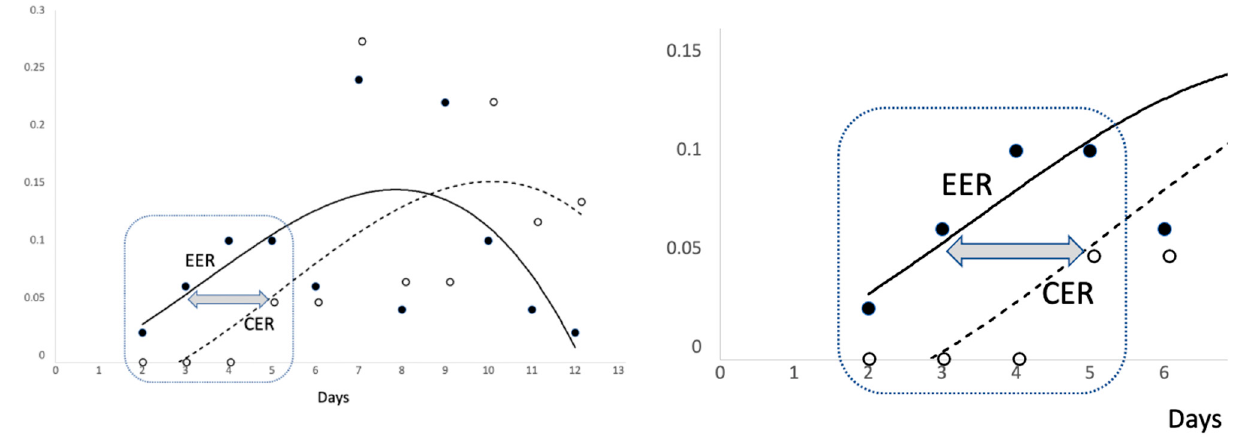
Figure 4. Experimental event rate (EER) and control event rate (CER) by days since initial positive and first negative SARS-CoV-2 swab test result. The two (dotted and continuous) lines represent a polynomial function of the third degree.